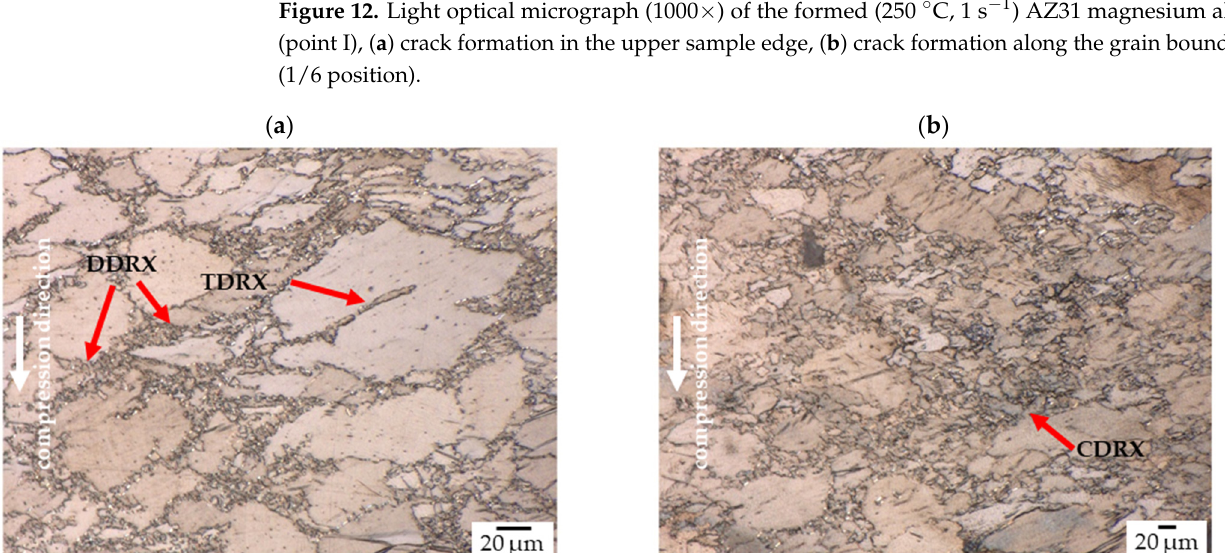
Figure 13. Light optical micrograph (1000×) of the transformed AZ31 magnesium alloy (1/6 position), ( a ) point II (300 °C, 0.01 s − 1 ): Necklace and TDRX, ( b ) Point III (350 °C, 0.01 s − 1 ): CDRX.